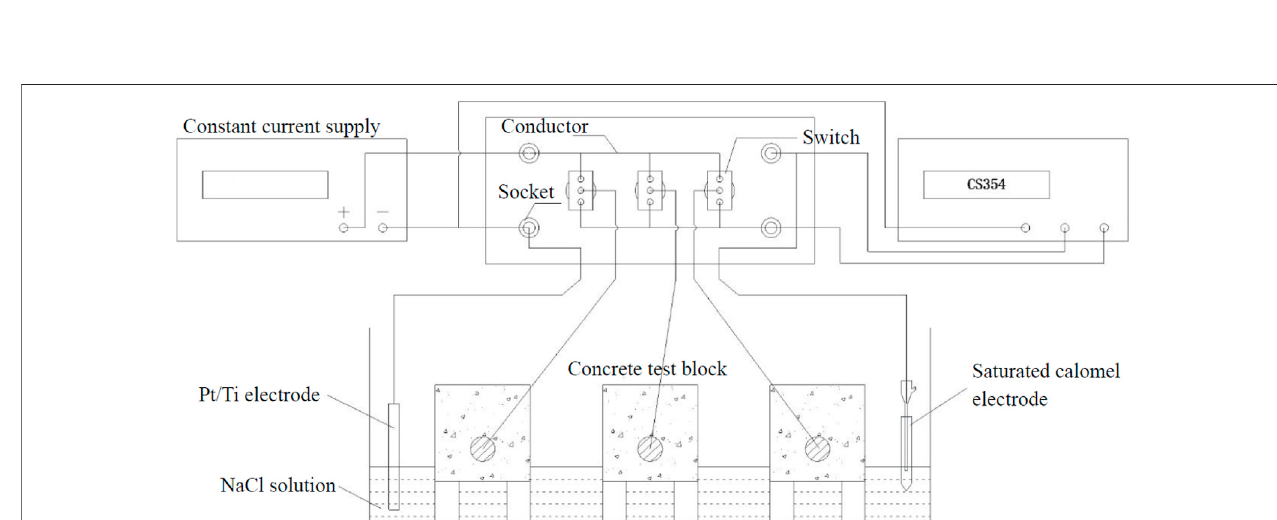
FIGURE 3 | Schematic diagram of the experimental